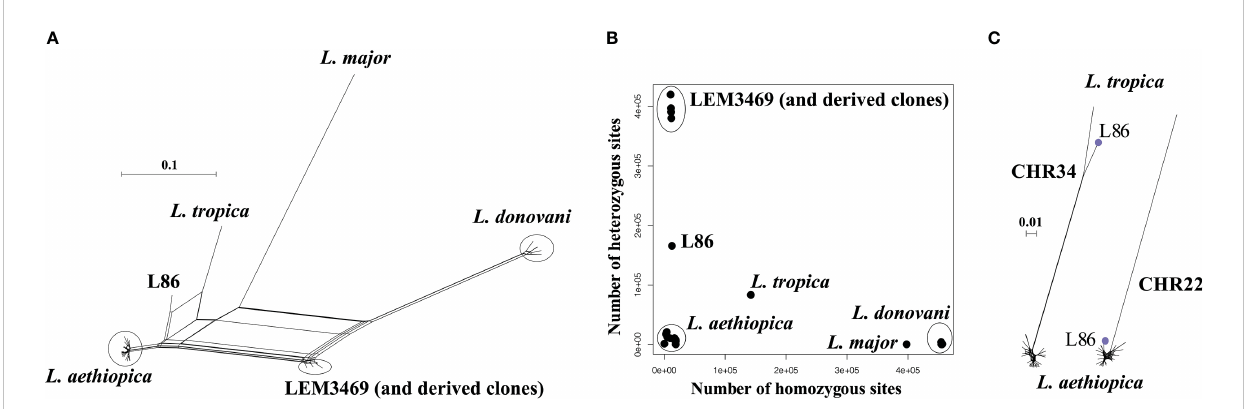
FIGURE 1 (A) Phylogenetic network based on SNPs called across 36 genomes of L. aethiopica , the L. donovani species complex, L. major and L. tropica . (B) Number of heterozygous sites versus number of homozygous sites for each of the 36 Leishmania genomes. (C) Phylogenetic network based on SNPs called in the last 700kb of chromosome 34 and the fi rst 300kb in chromosome 22. Blue dot indicates the position of the interspeci fi c L. aethiopica - L. tropica hybrid